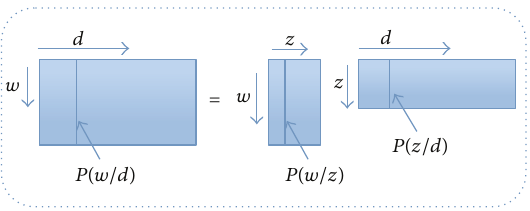
Figure 4: The graph representation of PLSA model.